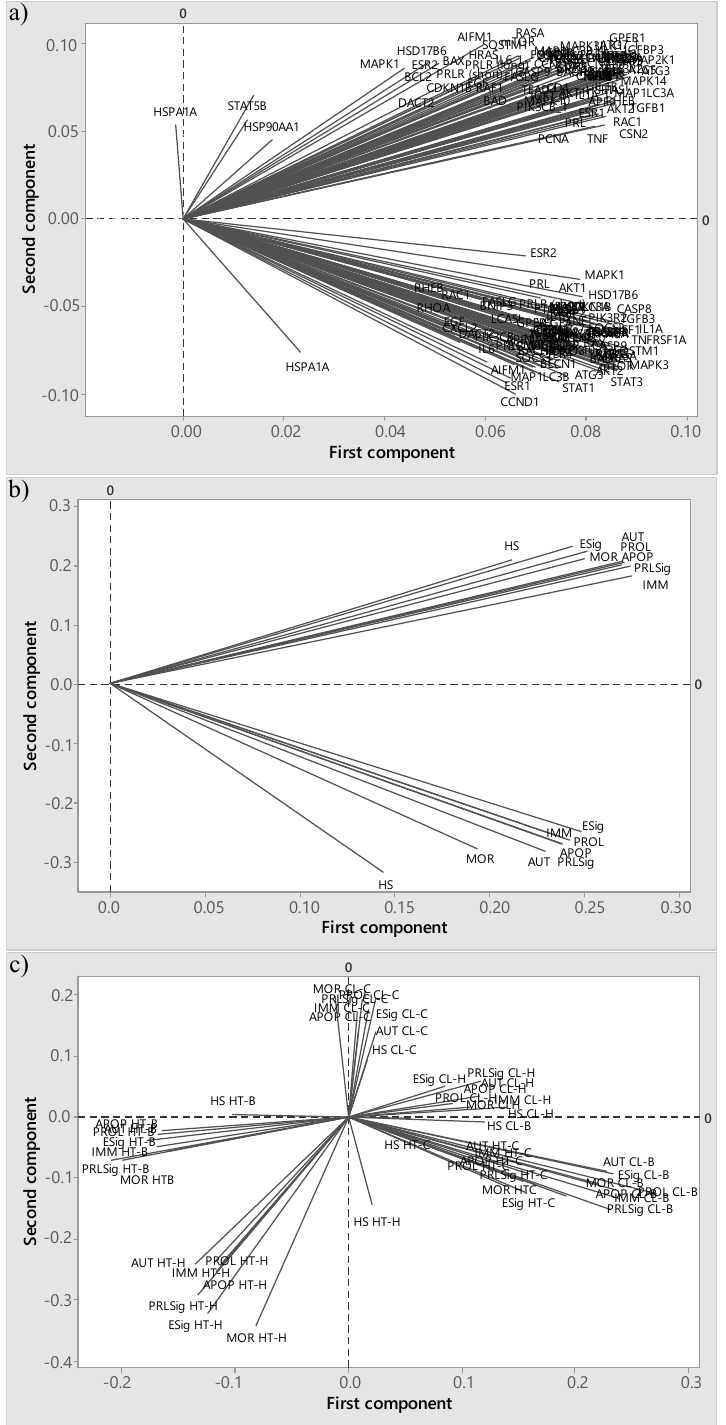
Figure 3. Loading plots describing relationships between: ( a ) mammary gland relative expression of 91 genes (as detailed in Table S1) and biopsy collection time point, ( b ) gene functions: heat shock (HS), prolactin signalling (PRLSig), oestrogen signalling (ESig), cell proliferation (PROL), autophagy (AUT), apoptosis (APOP), morphology (MOR), and immunity (IMM), and ( c ) in vivo and in vitro treatments from a principal component analysis. Figure 3c included genes averaged by in vivo and in vitro treatments CL-H, CL-C, CL-B, HT-H, HT-C, and